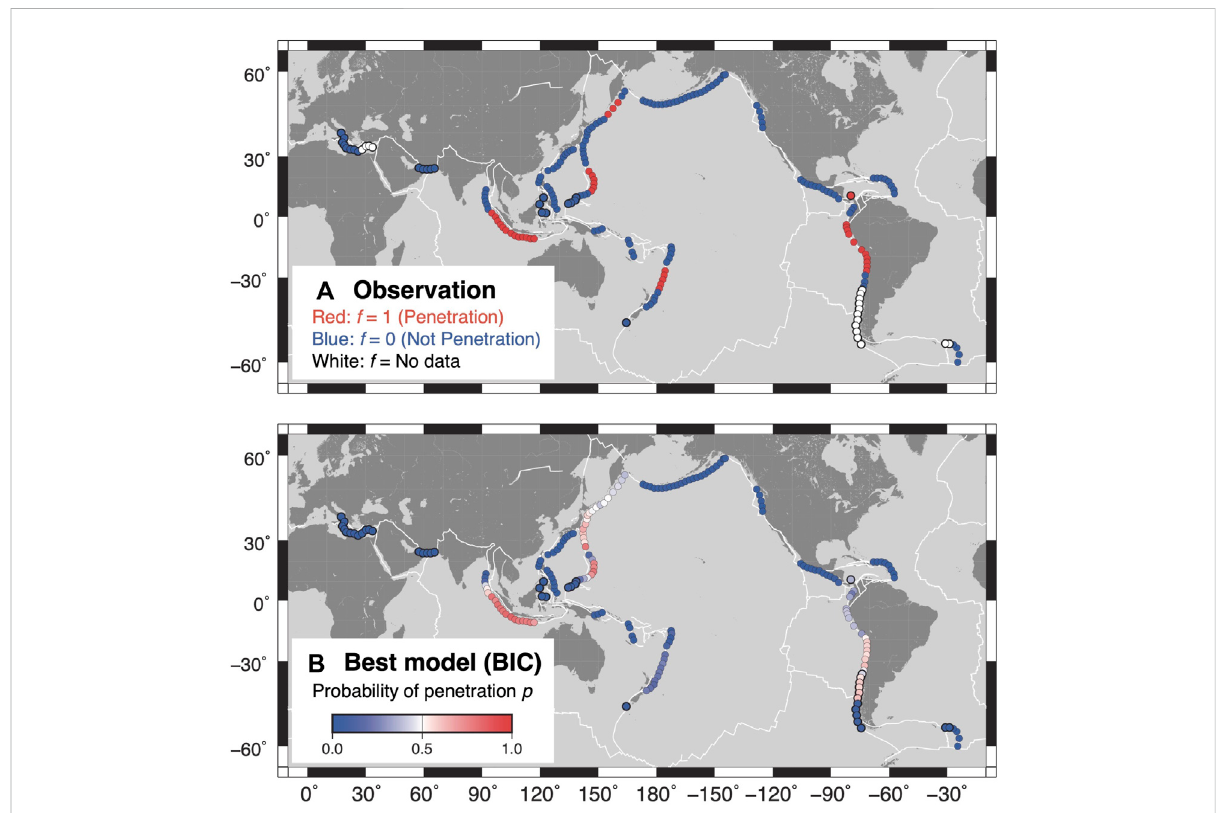
FIGURE 2 (A) Plate behavior at the 660-km discontinuity, f , which is based on the maximum plate depth de fi ned by SubMap 4.3 (Heuret and Lallemand, 2005). (B) Probability of the subducted oceanic plate penetrating the 660-km discontinuity, p BIC , which is calculated using the optimal model that yieldstheminimumBIC(blackbarsinFigure3).Circleswiththinblacklinesinboth fi guresindicatethesamplesusedfortraining,andthosewiththick black lines indicate test samples. White lines mark the plate